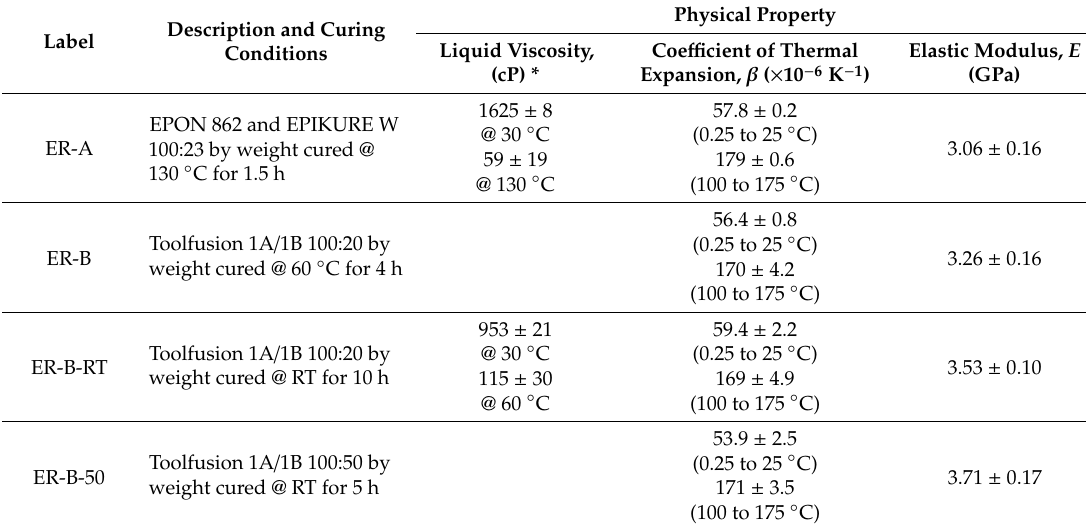
Table 1. Nomenclature and physical properties of epoxy